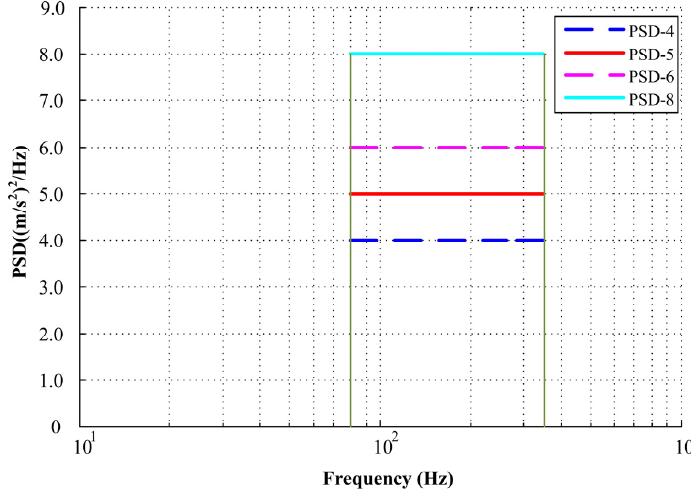
Figure 4. Flowchart of the proposed simulation method.